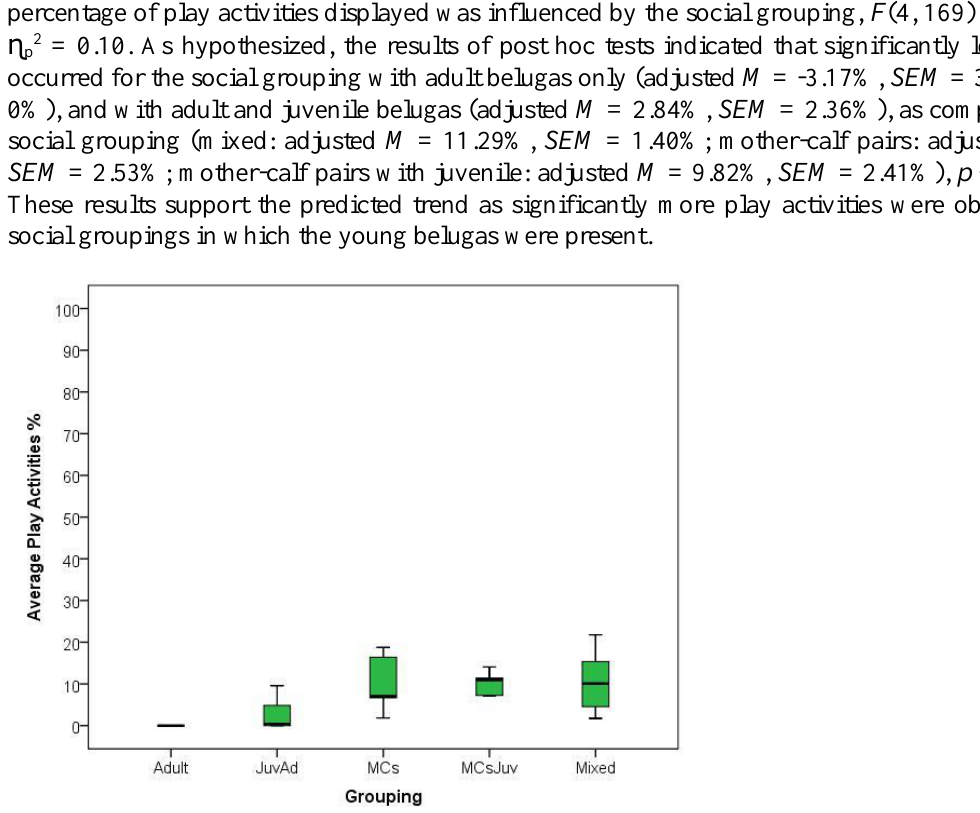
Figure 2. Boxplots of average play activities percentage per social grouping. Note the scale is a